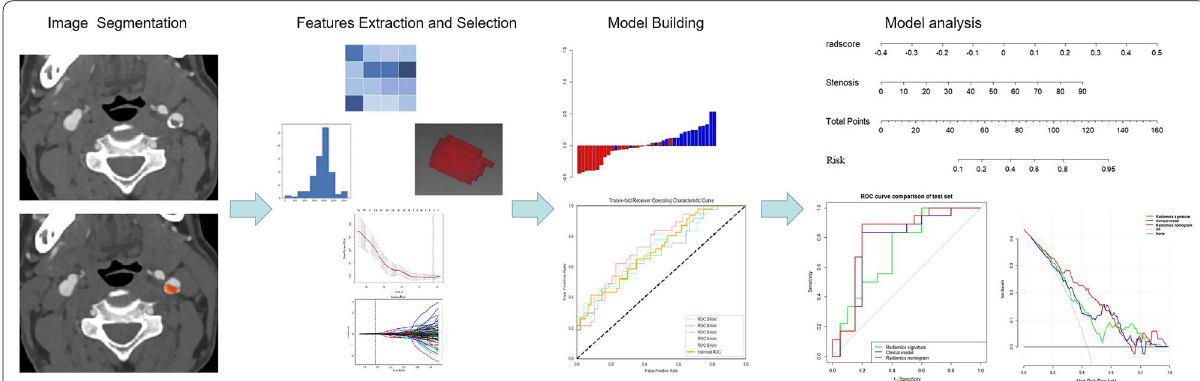
Fig. 2 Overall workflow of the radiomics model development